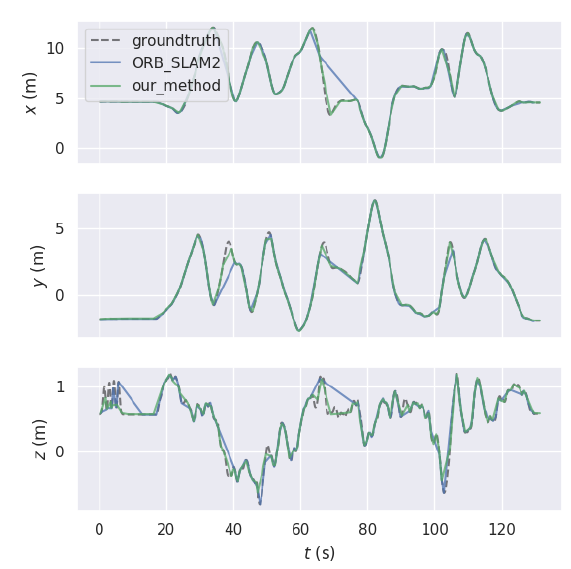
Figure 11. Trajectory of MH03 projected in xyz direction